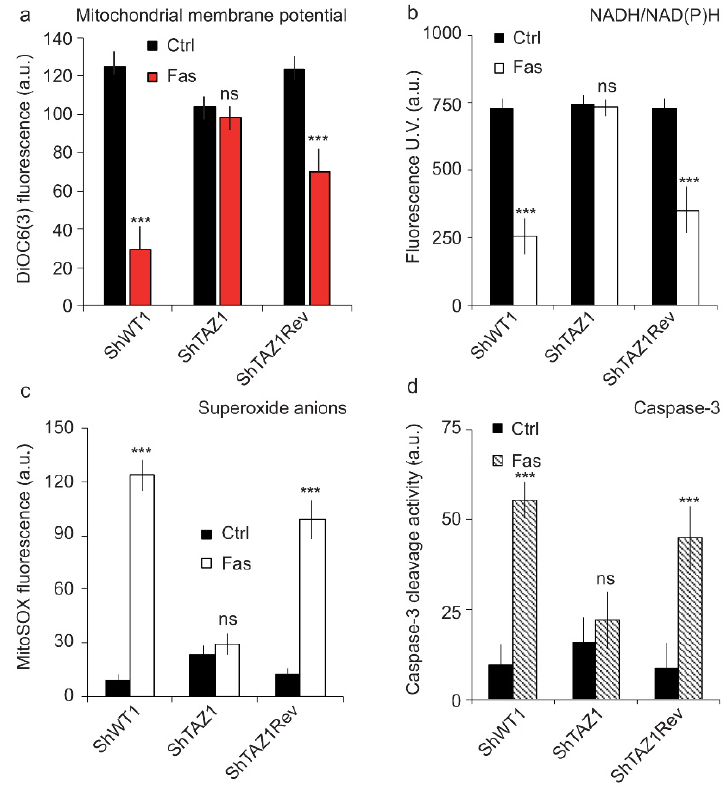
Figure 3. Flow cytometric analysis of the “canonical” early events of apoptosis that are affected in the tafazzin mutant cells (ShThaz1). ( a ) Measurement of the mitochondrial membrane potential ( ΔΨ m) with DiOC 6 (3) in the three cell lines when treated with Fas. ( b ) Estimation of the NAD(P)H reduction (The fluorescent NADH and NADPH give rise to non-fluorescent NAD + or NADP + ) in the three cell lines when treated with Fas, which is concomitant with potential changes in the mitochondrial membrane, when they occur. ( c ) Measurement of the superoxide anions produced by the defective mitochondrial electron transport chain during Fas-induced apoptosis. ( d ) Caspase-3 activity associated with cytochrome c release from the mitochondria when Fas-induced apoptosis is occurring. ns = no significant and *** is the p -value ≤ 0.001.